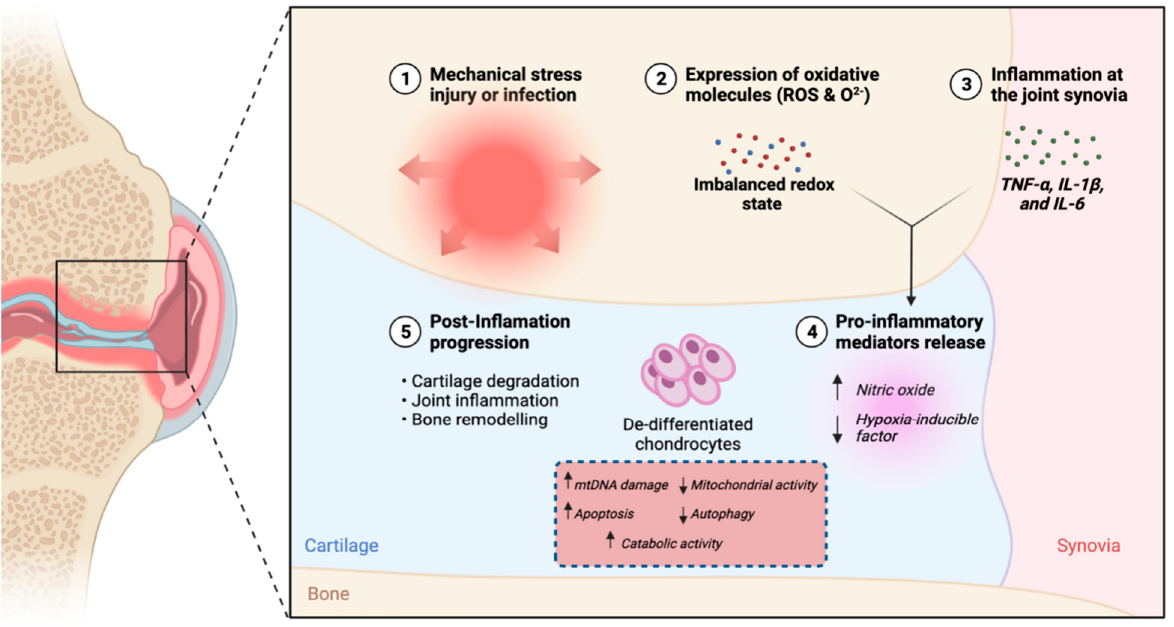
Figure 1. The consequences of inflammation of the articular cartilage inducing the production of NO, O 2 − and ROS under normoxia conditions, leading to severe joint dysfunction and blocking movement. Adapted from “Pathology of Osteoarthritis” by BioRender.com (2022). Retrieved from https://app.biorender.com/biorender-templates (accessed on 4 April 2022).